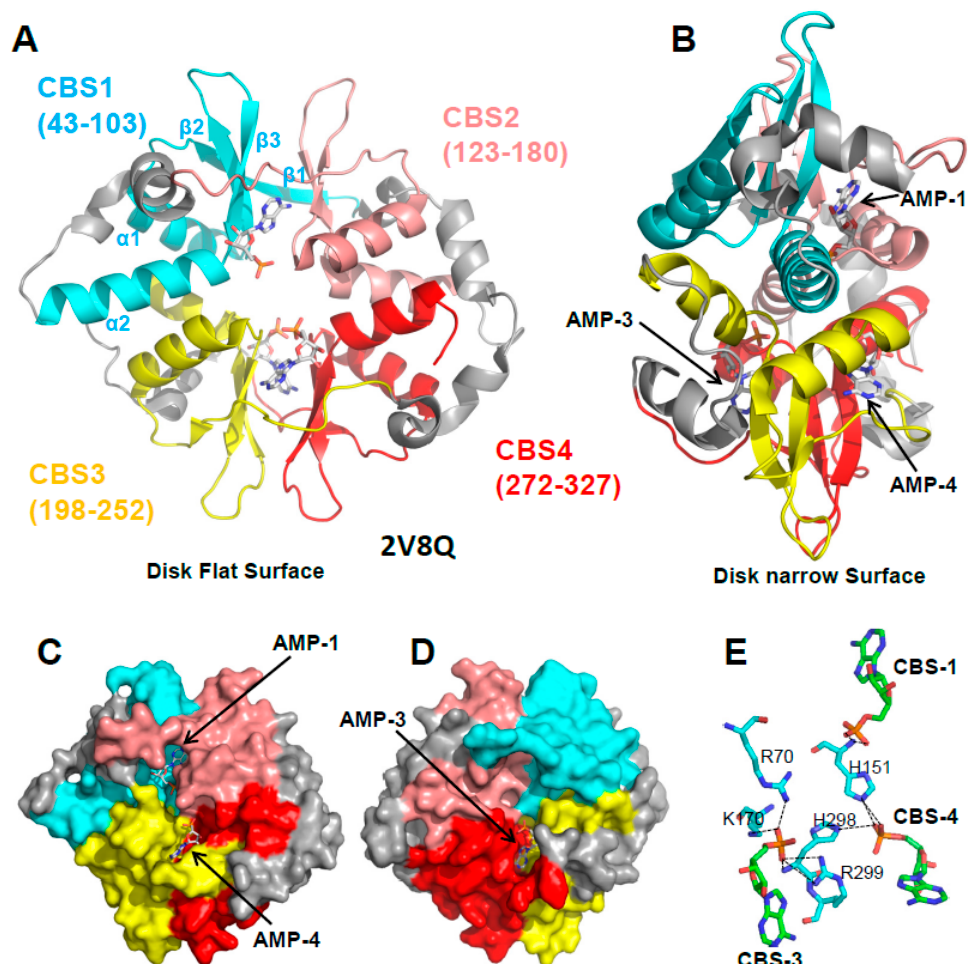
Figure 4. AMP binds three of the four CBS sites of the γ subunit. ( A , B ) Cartoon representation of the γ subunit in two different orientations. AMP molecules are shown in stick representation. The four CBS sites are shown in different colors with the secondary structure elements of CBS1 labeled. ( C , D ) Surface representation of the front and back sides of the disk flat surfaces illustrating the AMP-occupied binding pockets 1, 3, and 4, and the empty CBS2 pocket. ( E ) The phosphate groups (orange) of the three AMP molecules (cyan C atoms) coordinately interact with a set of polar γ subunit residues (green C atoms); O: red, N: